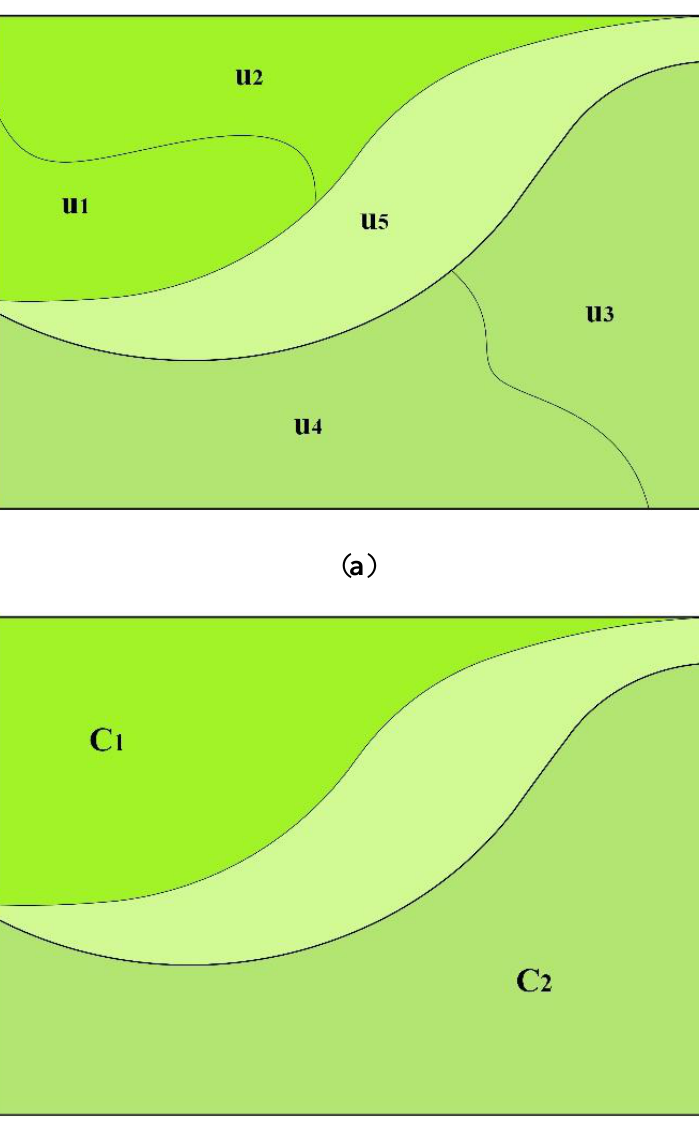
Figure 1. The relationships between a zone, a subregion and a zoning unit. ( a ) The units in a zone; ( b ) The subregions in a